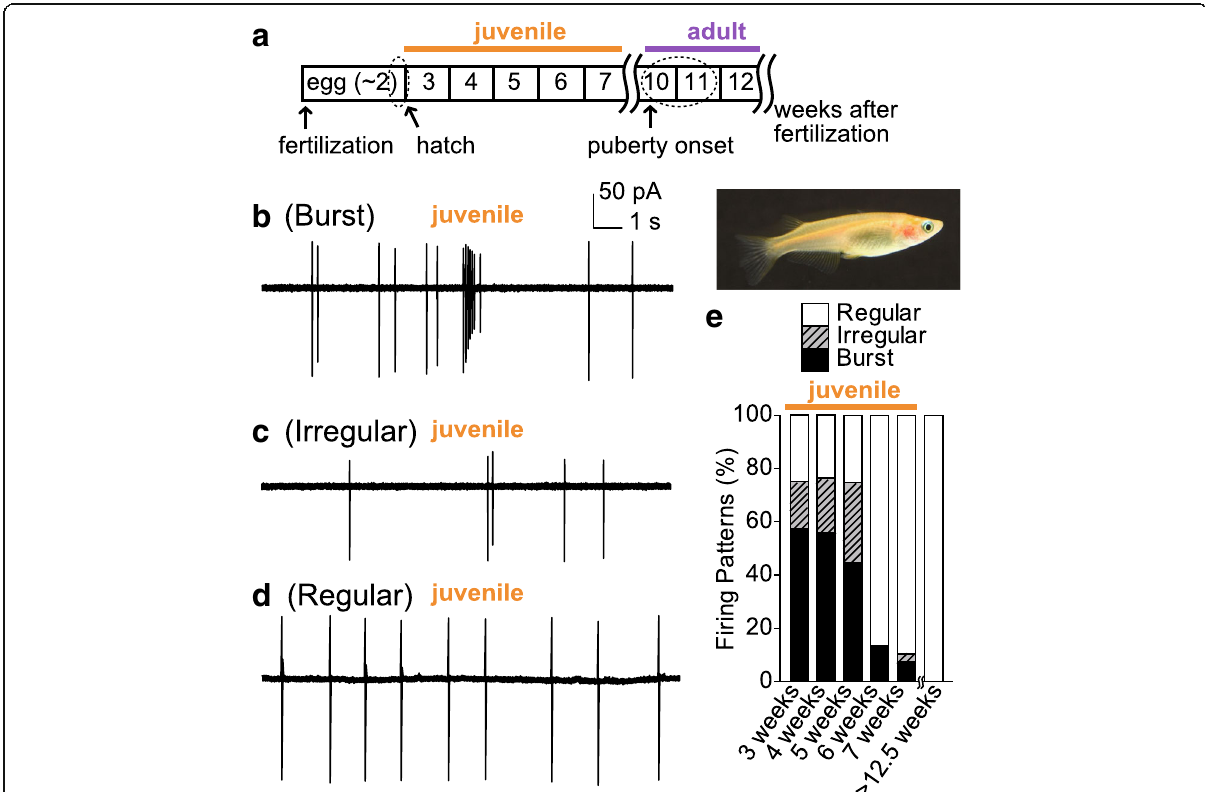
Fig. 3 Firing patterns of the terminal nerve GnRH neurons in juvenile medaka ( a ) A scheme of post-hatching development of medaka. ( b – e ) Representative firing patterns in medaka. The firing patterns in B and C were recorded from medaka 4 weeks after fertilization, and that in D from medaka 7 weeks after fertilization. The time and current scales shown in the upper right corner of B apply to B – D. ( e ) Categorized firing patterns of TN-GnRH3 neurons in one typical fish for each stage. We used the average value for each pattern. The classification of the firing pattern is as follows: burst firing, consecutive spikes more than three at > 3 Hz (firing frequency in adult medaka is usually lower than 2 Hz) and interburst interval longer than 1 second (longer than that of typical TN-GnRH3 neurons in adults); regular firing, coefficient of variation of the interburst interval < 0.65 (the coefficient of variation is defined as the ratio of the standard deviation to the mean interburst interval); irregular firing, others. Juvenile: 3 weeks after fertilization, nine fish; 4 weeks, nine fish; 5 weeks, seven fish; 6 weeks, eight fish;7 weeks, eight fish. Adult: > 12.5 weeks, four fish. These figures were modified from Umatani and Oka, 2018